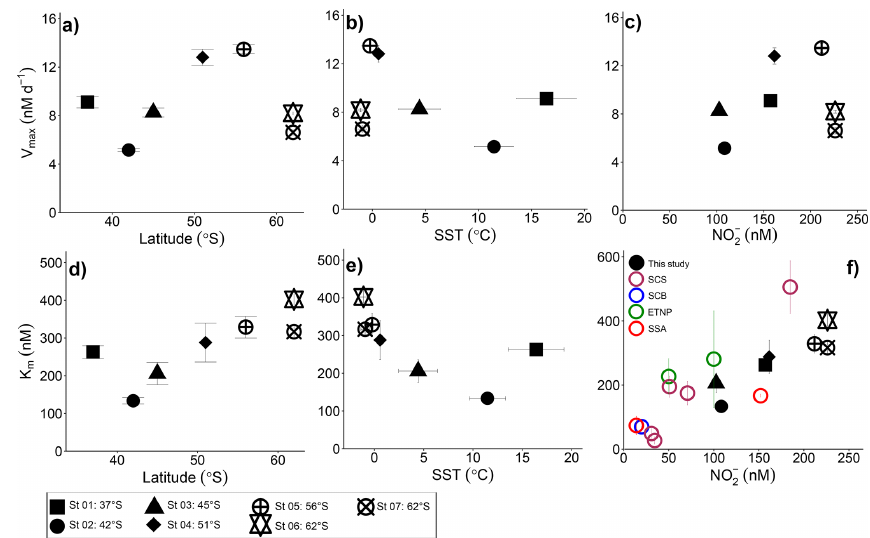
Figure 4. Potential controls on the kinetic parameters associated with NO − oxidation. V max and K m are shown as a function of (a, d) latitude, 2 (b, e) sea surface temperature (SST), and (c, f) the ambient nitrite concentration ([NO − ] amb ) . Vertical error bars show the propagated error 2 associated with V max and K m computed using a nonlinear, least-squares optimization method (SciPy lmfit package, Python 3.7.6), while the symbols and horizontal error bars in (b, e) indicate the average ( ± 1 standard deviation) SST experienced by the sampled communities during the incubations. In (f) black symbols show our Southern Ocean data, maroon symbols show K m values from the South China Sea (SCS; Zhang et al., 2020), the blue symbol shows the K m value derived for the Southern California Bight (SCB; Olson 1981a), the green symbol shows K m values from the eastern tropical North Pacific oxygen deficient zone (ETNP; Sun et al. 2017), and the red symbols show K m values derived for the subtropical southeast Atlantic (SSA; Sarah Fawcett et al., unpublished